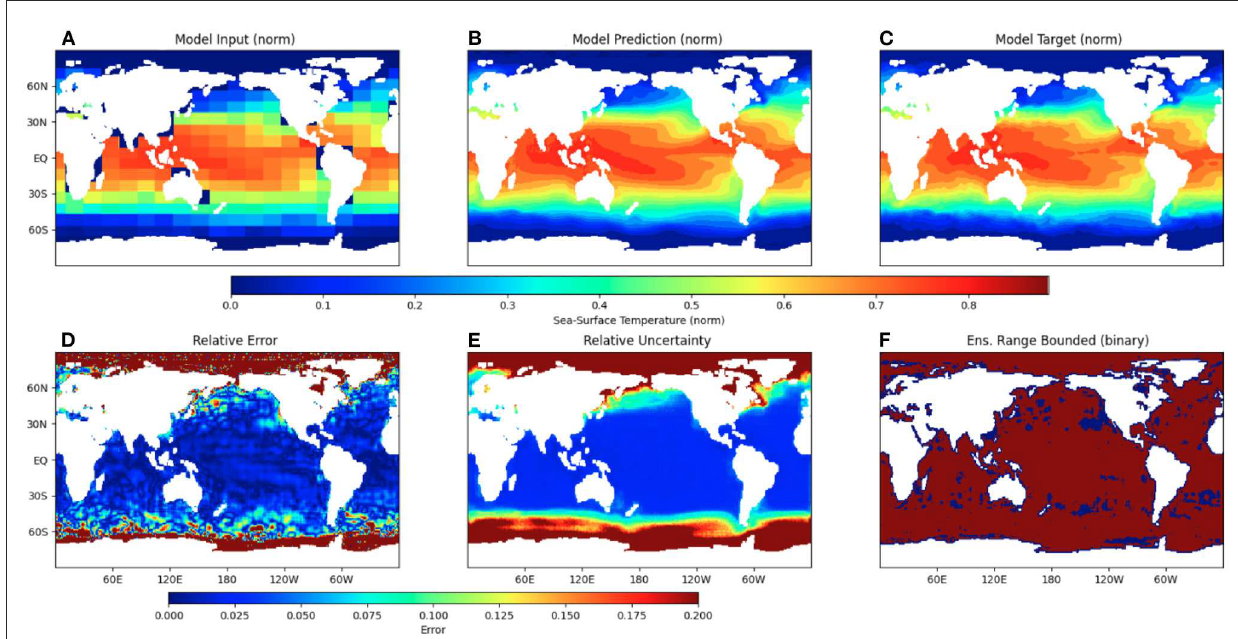
FIGURE6 Results for an unseen test snapshot from the NOAA sea-surface temperature dataset (Reynolds et al., 2002, 2007). (A) Shows the tessellated input field, (B) the contours of the predicted temperature field, (C) the contours of the target temperature field, (D) the relative error field, (E) the relative uncertainty field, and (F) the regions where the range of the predicted ensemble bounds the prediction error, represented as a binary color-coded plot where red indicates a pixel is bounded, and blue indicates it is not.